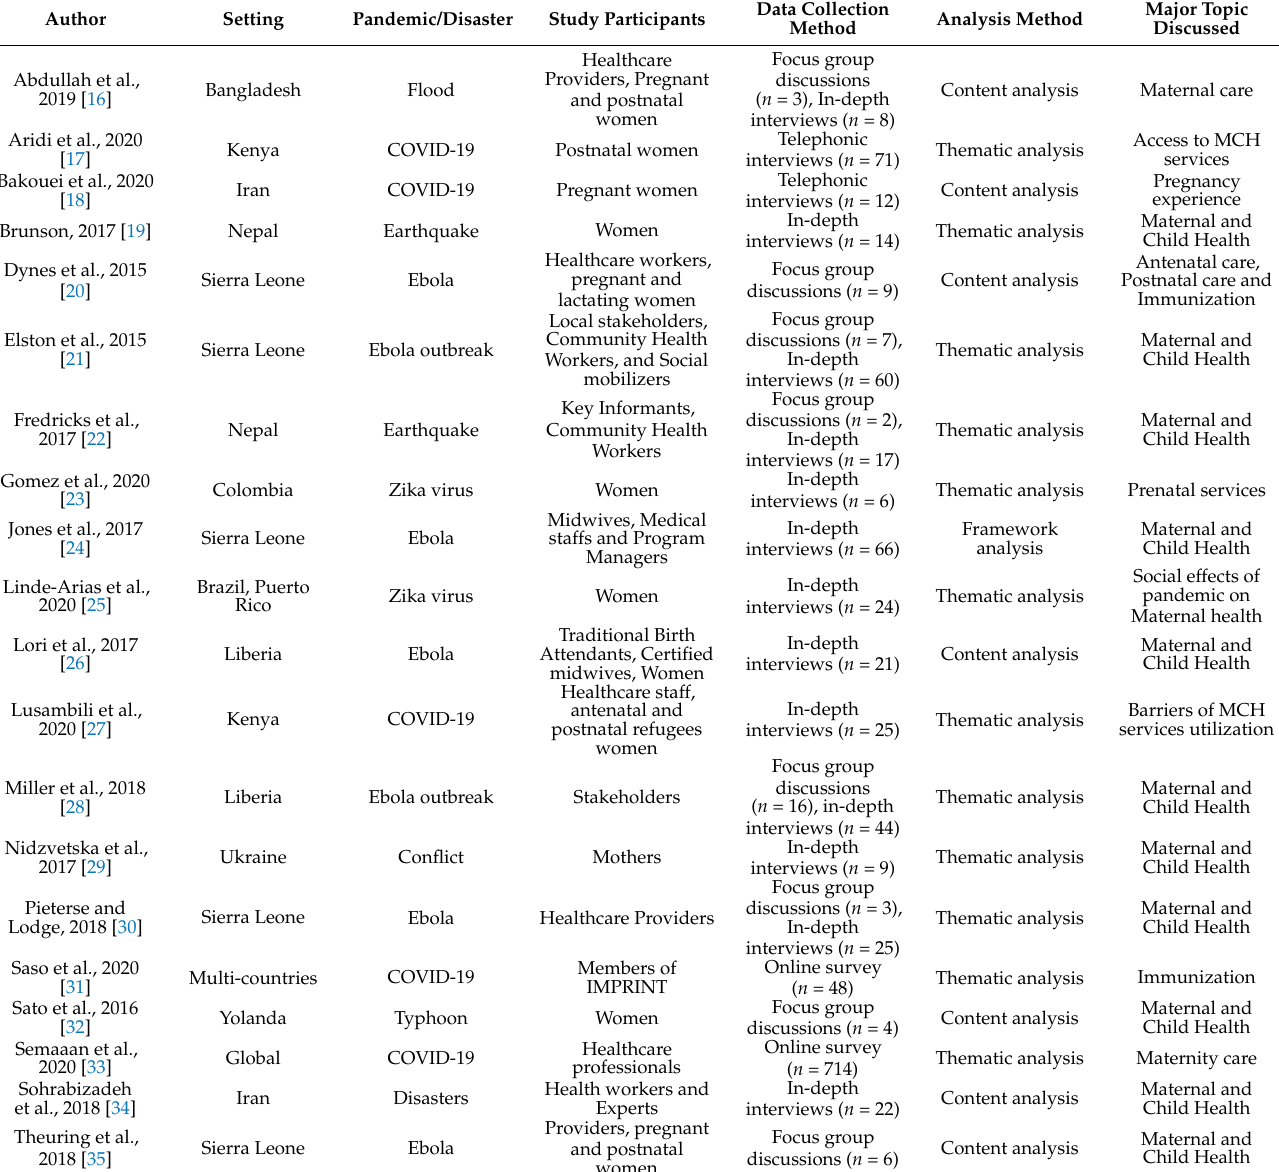
Table 1. Characteristics of the selected